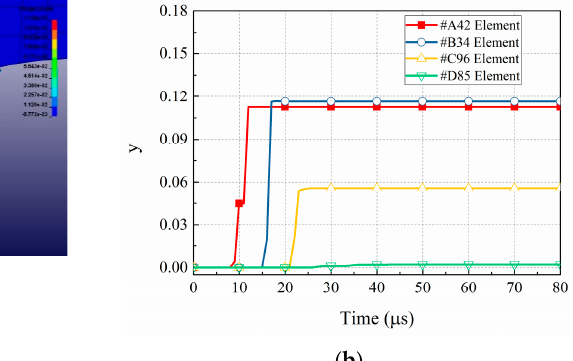
RMs at an impact velocity of 1300 m/s: ( a ) location of elements; ( b ) time-history curves of the extent of